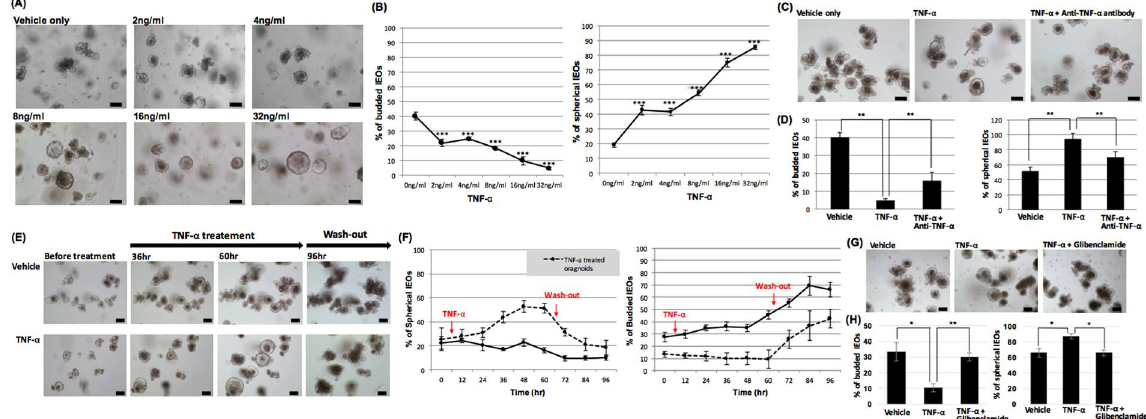
Figure 5. TNF- α treatment results in spherical morphologic changes in IEOs. ( A ) Representative images showing IEOs with TNF- α treatment. Bars, 100 μ m ( B ) The percentage of budded (left) or spherical (right) IEOs among all the IEOs that were treated with TNF- α was determined. ( C ) Representative images showing TNF- α treated IEOs with or without TNF- α neutralizing antibodies. Bars, 100 μ m ( D ) The percentage of budded (left) or spherical (right) IEOs among all the IEOs that were treated with TNF- α neutralizing antibody was determined. ( E ) Time-course images of when TNF- α was removed from the TNF- α treated IEO media. Bars, 100 μ m ( F ) The percentage of spherical (left) or budded (right) IEOs among all the IEOs that were initially treated with TNF- α and then removed was determined. ( G ) Representative images of TNF- α treated IEOs with or without glibenclamide. Bars, 100 μ m. ( H ) The percentage of budded (left) or spherical (right) IEOs among all the IEOs treated with glibenclamide was determined. Data are presented as the mean ± SEM; n = 4 samples per bar, *** p < 0.001, ** p <